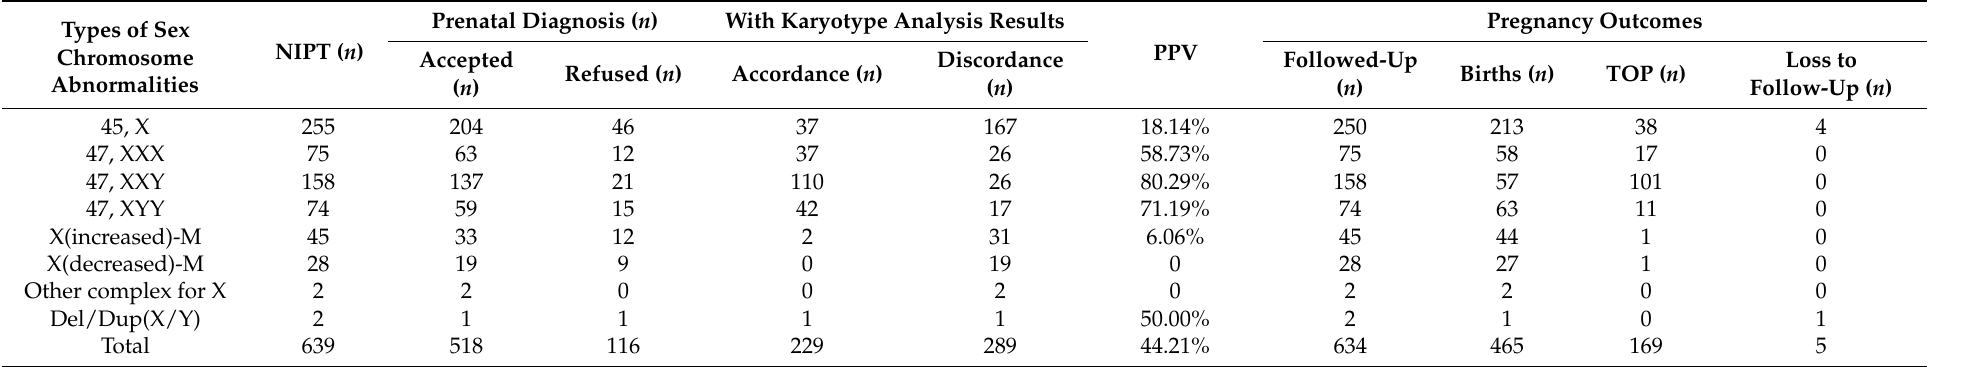
Table 2. Application of NIPT in the detection of fetal sex chromosome abnormalities and pregnancy outcomes.